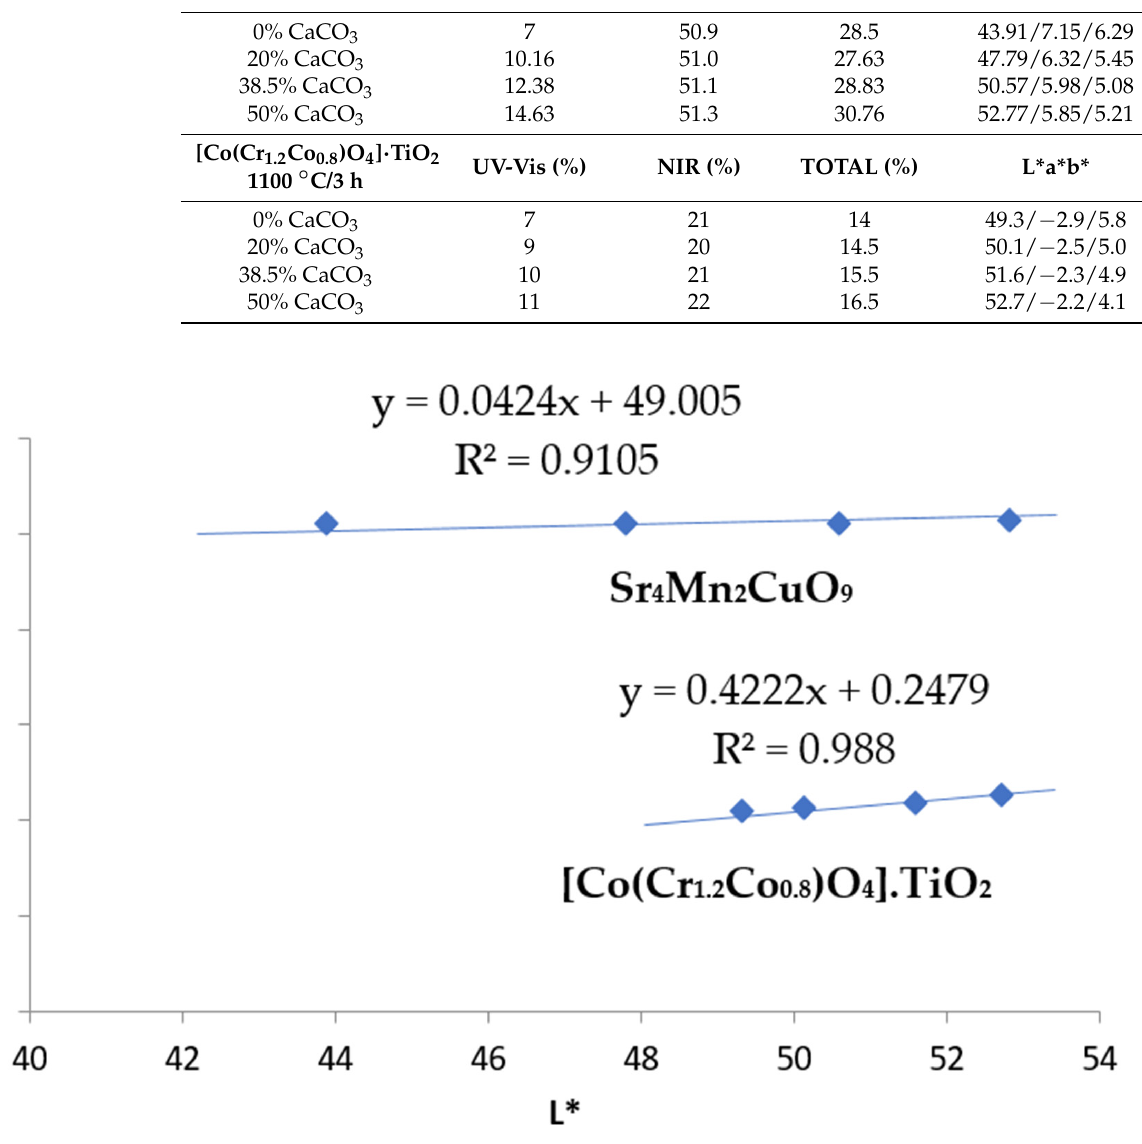
Table 6. L*a*b* values for the applications of pigments: (a) 10 wt.% in colourless alkyd paint, (b) 3